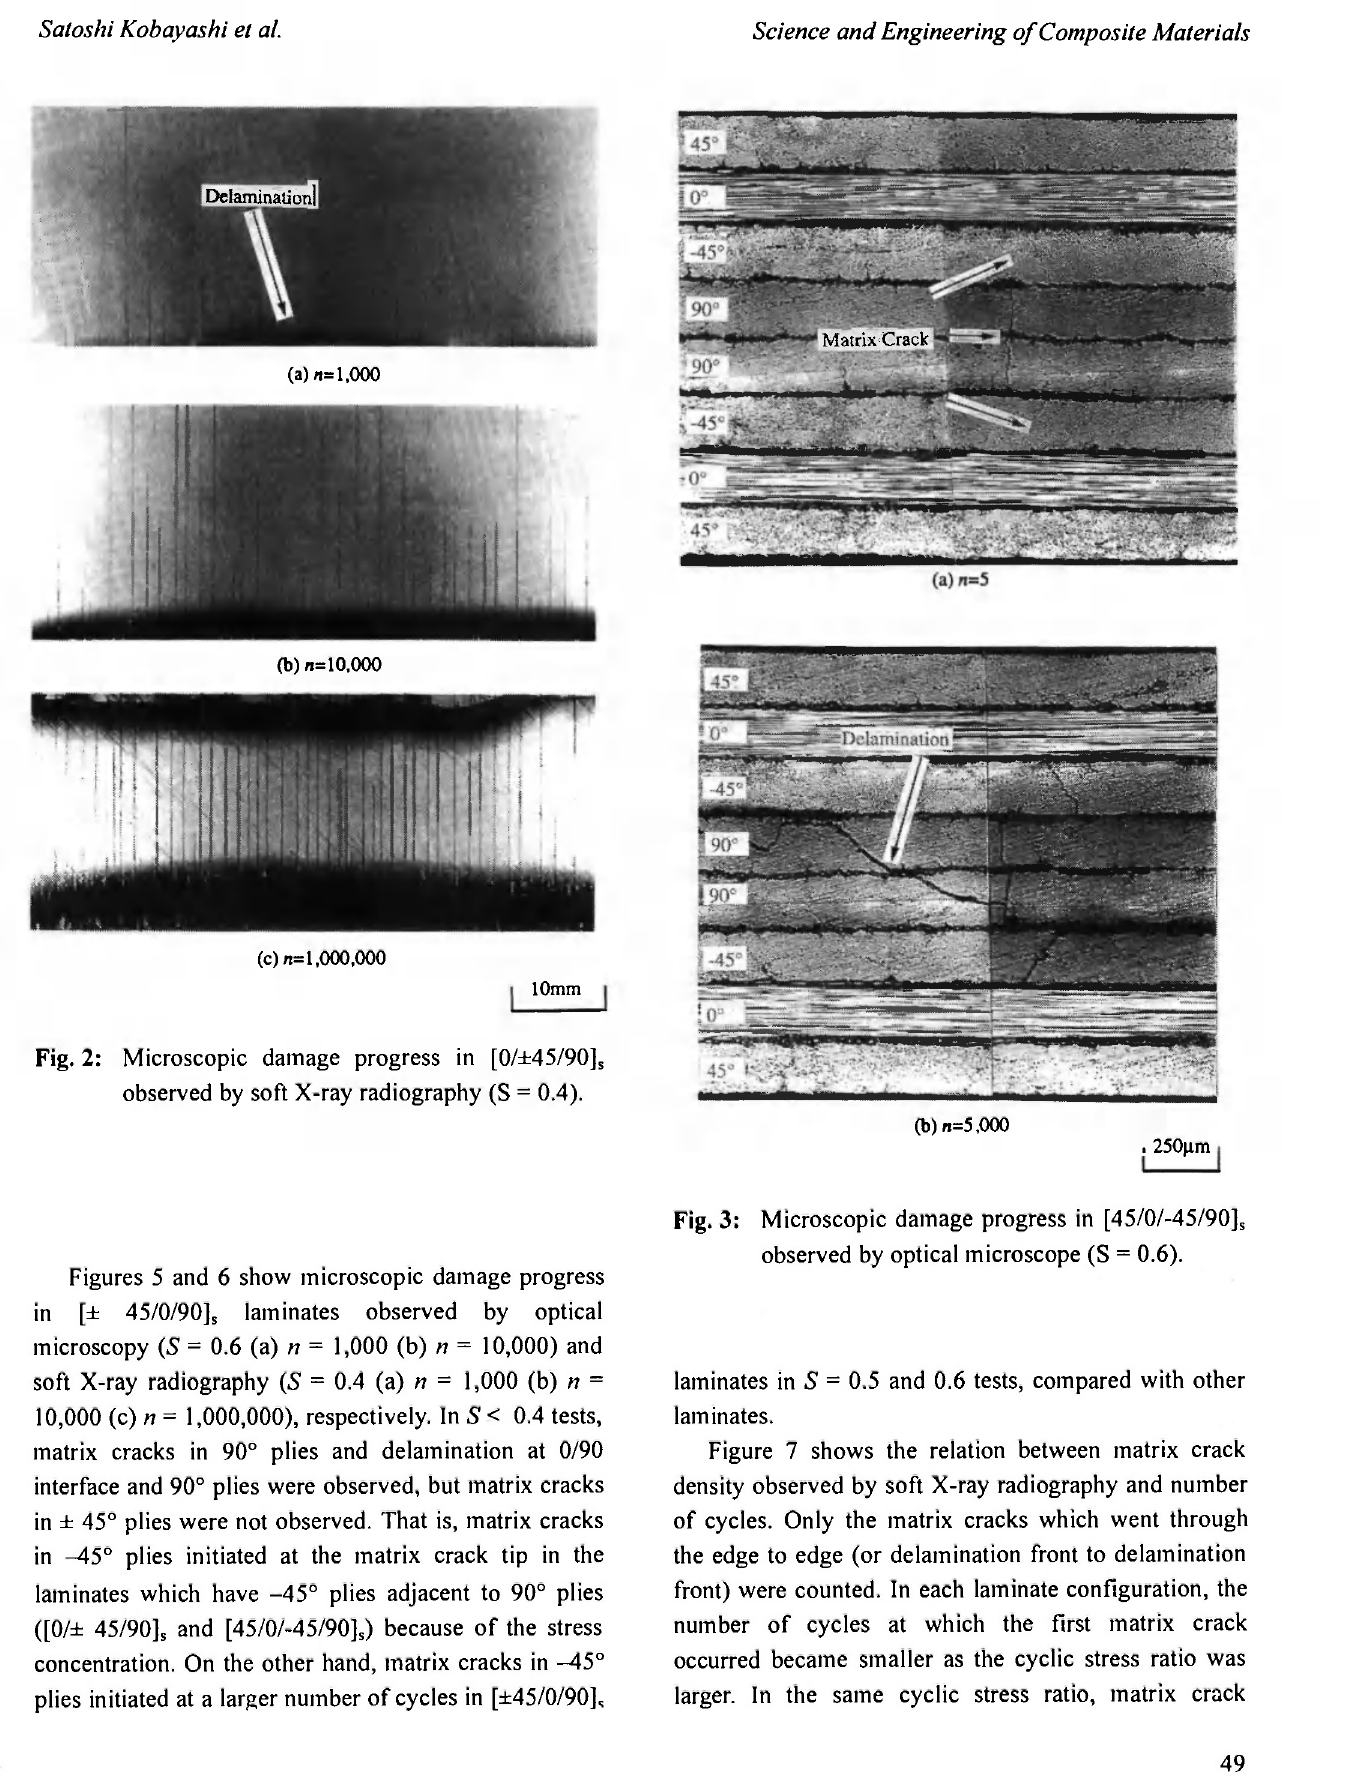
Fig. 2: Microscopic damage progress in [0/±45/90] s observed by soft X-ray radiography (S =